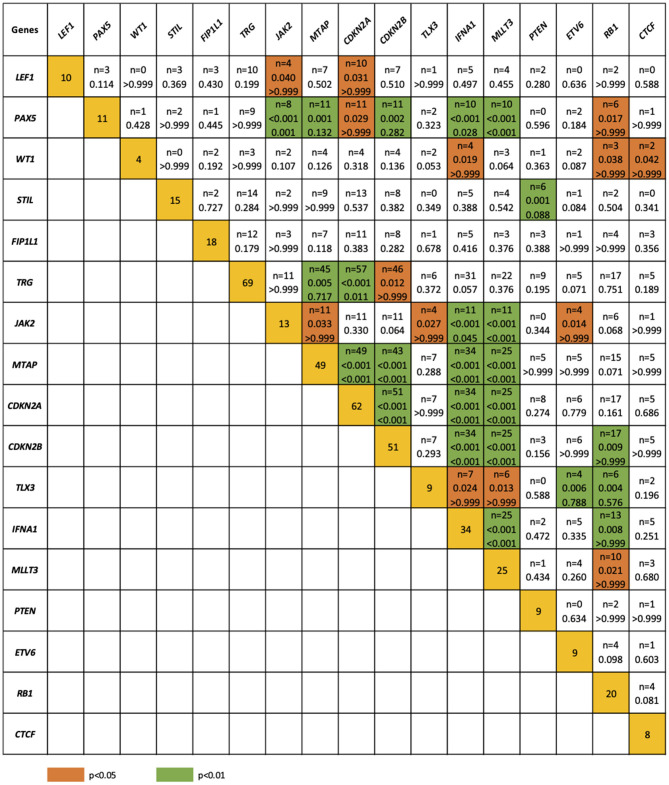
Concomitance of gene deletions in 86 children with T-ALL. Yellow boxes indicate the total number of patients with a deletion. Other boxes indicate the number of patients with two specific abnormalities. Orange and blue colors indicate significant overlap associations in individual comparisons (p < 0.01 or p < 0.05), respectively. If association in individual comparison of two genes was significant, p-value corrected for multiple comparisons was added.